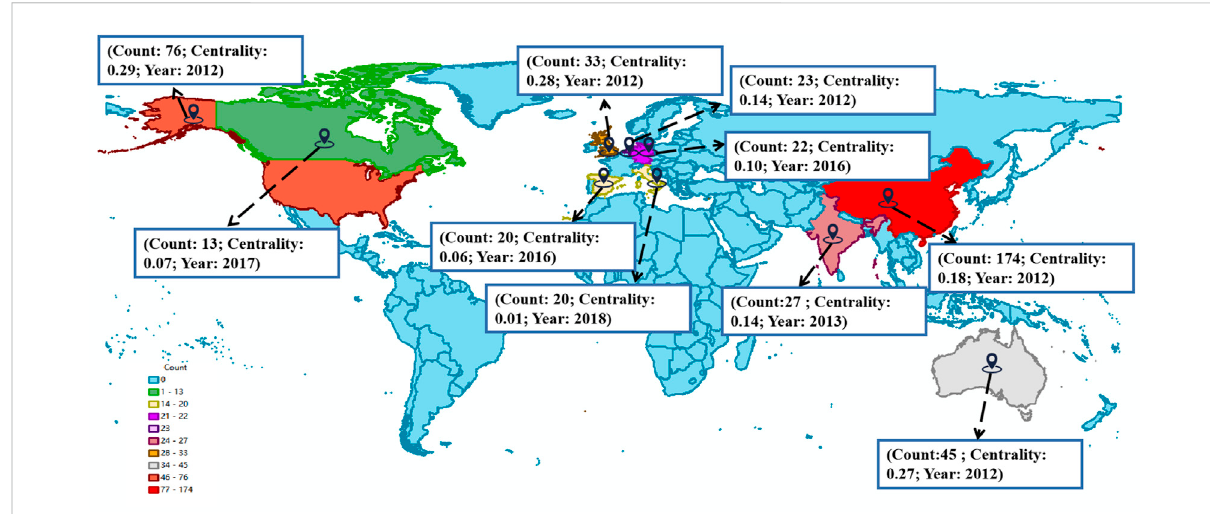
FIGURE 4 Geographical distribution of the top ten countries.Count: Number of publications by country. Year: The year the publications were originally published in a country. Centrality: The importance of each article in the co-citation network.(The color of the top ten countries in the fi gure represents the number of their posts.The China region in the picture only includes the mainland